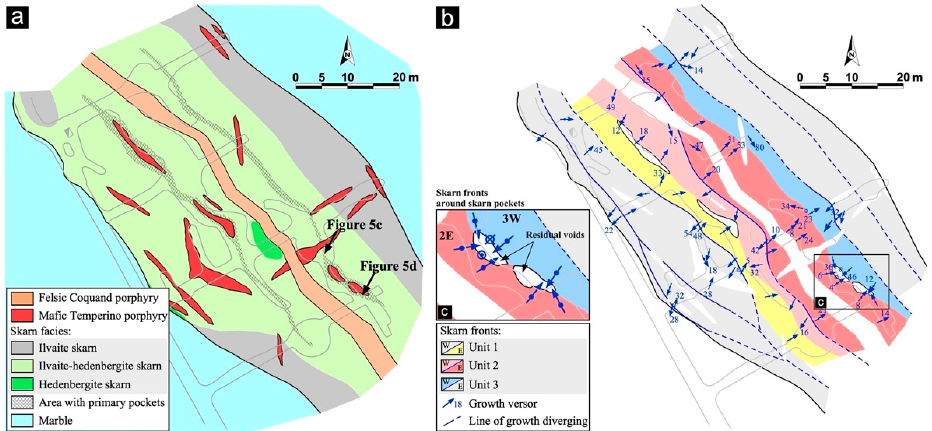
Figure 6. ( a ) Geological map of the middle part of level 3-Earle body (Temperino mine; modified from [15]). The main large primary skarn pockets are located inside the skarn body, as indicated by the hatched areas. ( b ) Skarn mineral growth versors (blue arrows - number referred to plunge) and traces of plane from which mineral growth versors diverge (blue lines - solid: well constrained plane traces; dotted: inferred plane traces; modified from [15]). The main large primary skarn pockets are located in the middle between two different planes at the contact between two skarn front units. In this figure, only the central skarn units are colored (yellow, pale and bright red, and blue colors). Note that some magmatic dykes cut the traces of plane from which mineral growth versors diverge. ( c ) Close-up of the contact zone between two skarn propagation front units, with primary skarn pocket (later filled by mafic porphyry); the skarn growth versors are centripetal with respect to the pockets.